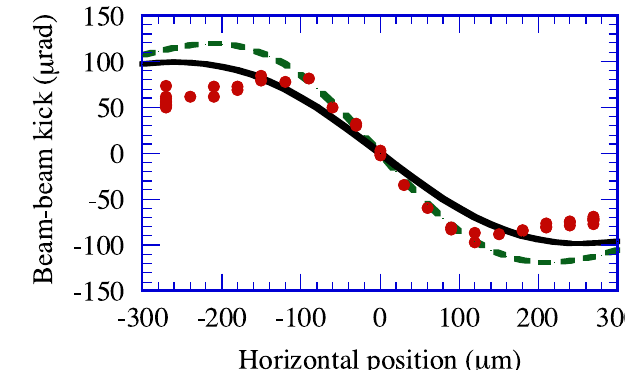
FIG. 13. (Color) The red dots represent a beam-beam kick as a function of the horizontal position, measured at a bunch current product of 0 : 4 mA 2 . The dashed green line represents a beam- beam kick with an effective size of 162 (cid:3) m considering the dynamic beam-beam effect. The solid black line represents a beam-beam kick with an effective nominal size of 196 (cid:3) m . The kicks were calculated, assuming a Gaussian